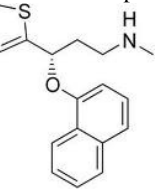
Figure 1. Chemical structure of